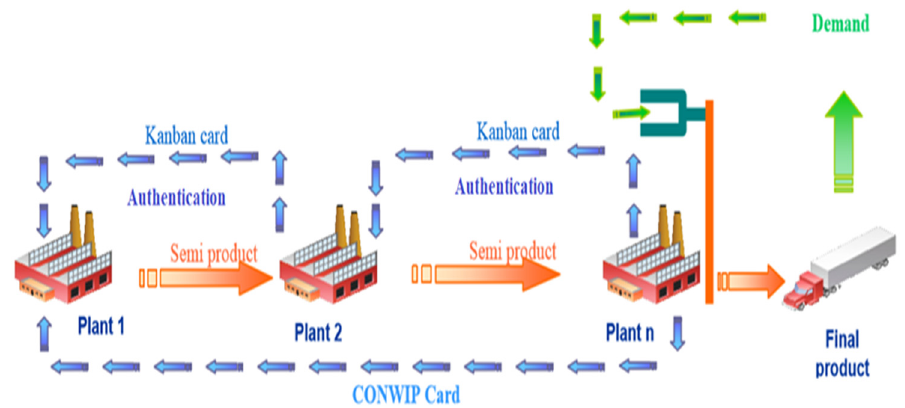
Figure 2. Proposed Secure Pull Manufacturing System.